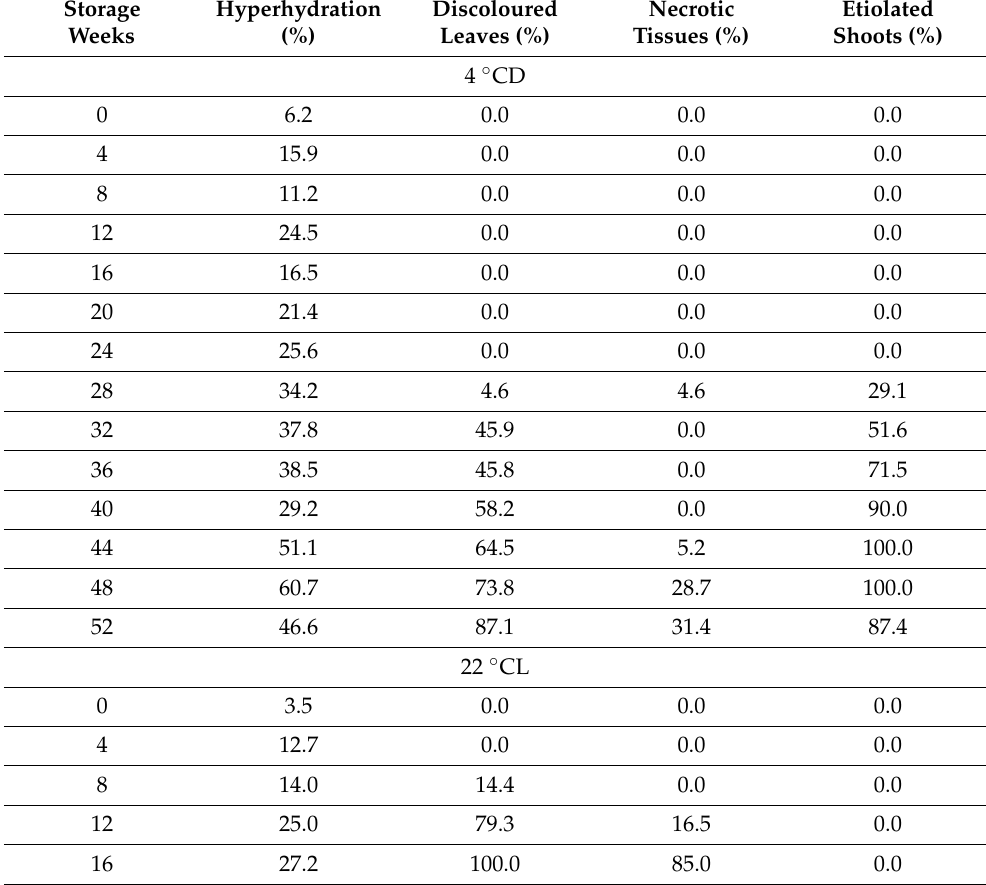
Figure 4. Shoot cultures of Sorbus redliana ‘Burokvölgy’ after storage at 22 °CL and 16 h light for four weeks ( A ), 8 weeks ( B ), 12 weeks ( C ), and 16 weeks ( D ). Table 1. The rate of physiological changes observed for the in vitro shoot culture of S. redliana ‘Burokvölgy’ stored under cold condition (4 °CD) and the growth chamber (22 °CL).